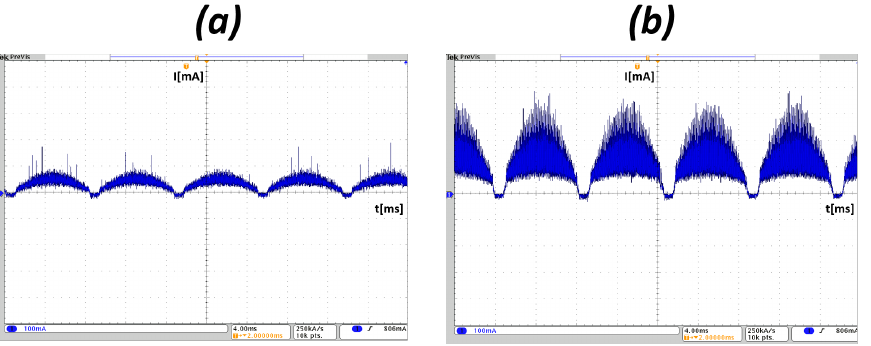
Figure 10. ACU-LUM output currents at 20% ( a ) and 70% ( b ) of the luminaire’s total luminous